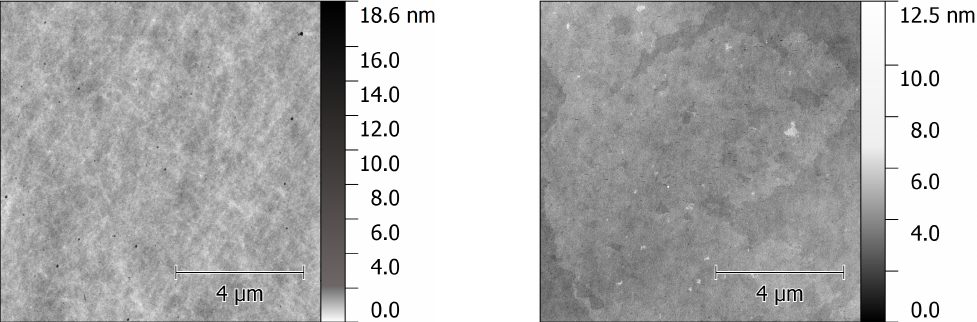
Figure 3. AFM scans of the surfaces. Samples with various concentrations of chromium: AFM of pure DLC (left), DLC with 15-17 at. % of Cr (right).